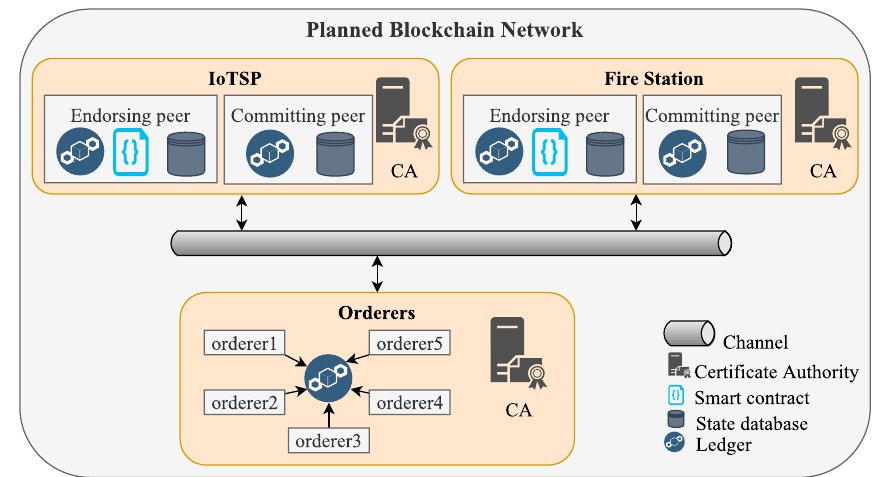
Fig. 6 Hyperledger Fabric’s Blockchain network of two organisations: IoTSP and firefighting